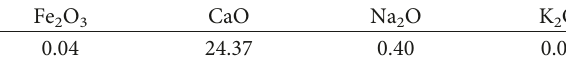
Table 3: Oxide composition of synthesized CA